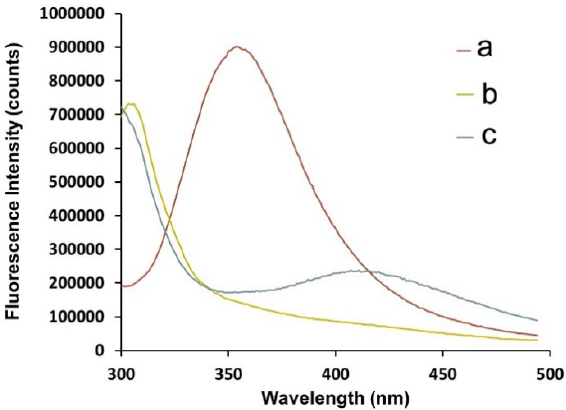
Figure 5. Representative fluorescence spectra of ( a ) unpurified Au-GSH-(Trp) purified Au-GSH-(Trp) with an O.D. of 0.60 before cyanide etching in 10 mM sodium 2 phosphate buffer pH 8.0 and ( c ) after cyanide etching in